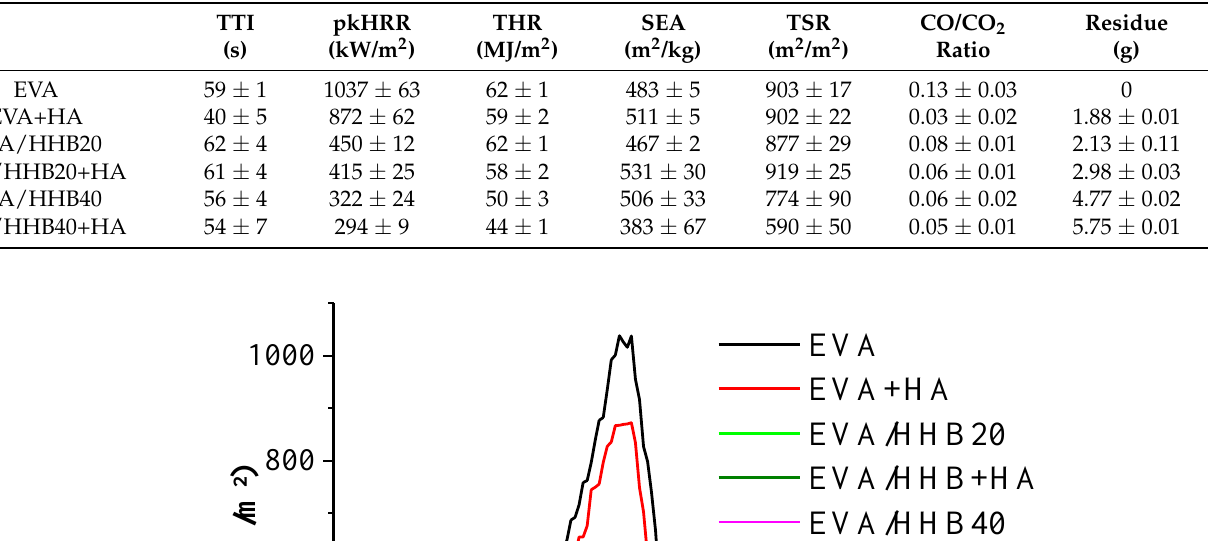
Table 3. Main thermal and smoke parameters by cone calorimetry tests.